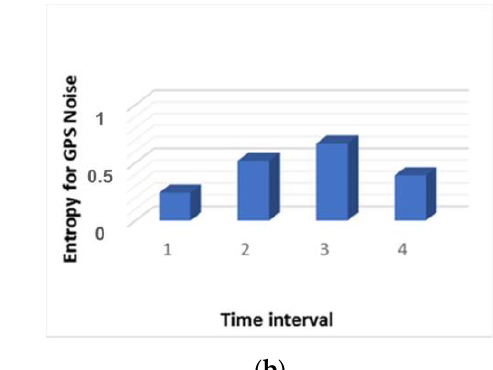
Figure 2. The result of calculating the Kullback-Leibler divergence for the indicator “number of GPS satellites” at the time of the attack.